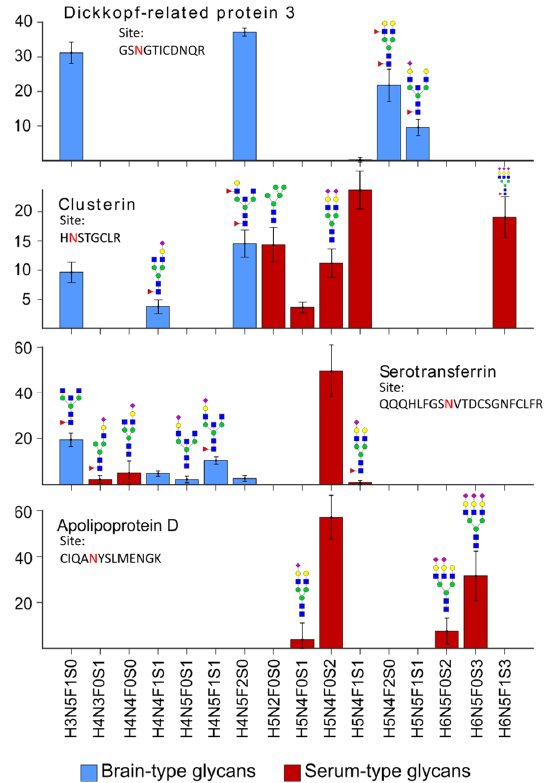
Figure 3. Glycopeptide profiles as average over eleven control samples for four different glycoproteins. Glycans with at least two brain ‐ type features (fucosylation, bisecting N ‐ acetylglucosamine, and truncated antenna) are colored in blue and glycans with blood ‐ type features are colored in red. Purely brain ‐ derived proteins such as dickkopf ‐ related protein 3 mainly show brain ‐ type glycans. Proteins which are expressed in multiple tissues, such as transferrin or clusterin, show glycan structures which are commonly found on blood proteins but also brain ‐ type glycans in lower abundance. Apolipoprotein D shows only blood ‐ type glycans, which can be explained by its low expression in brain tissue.